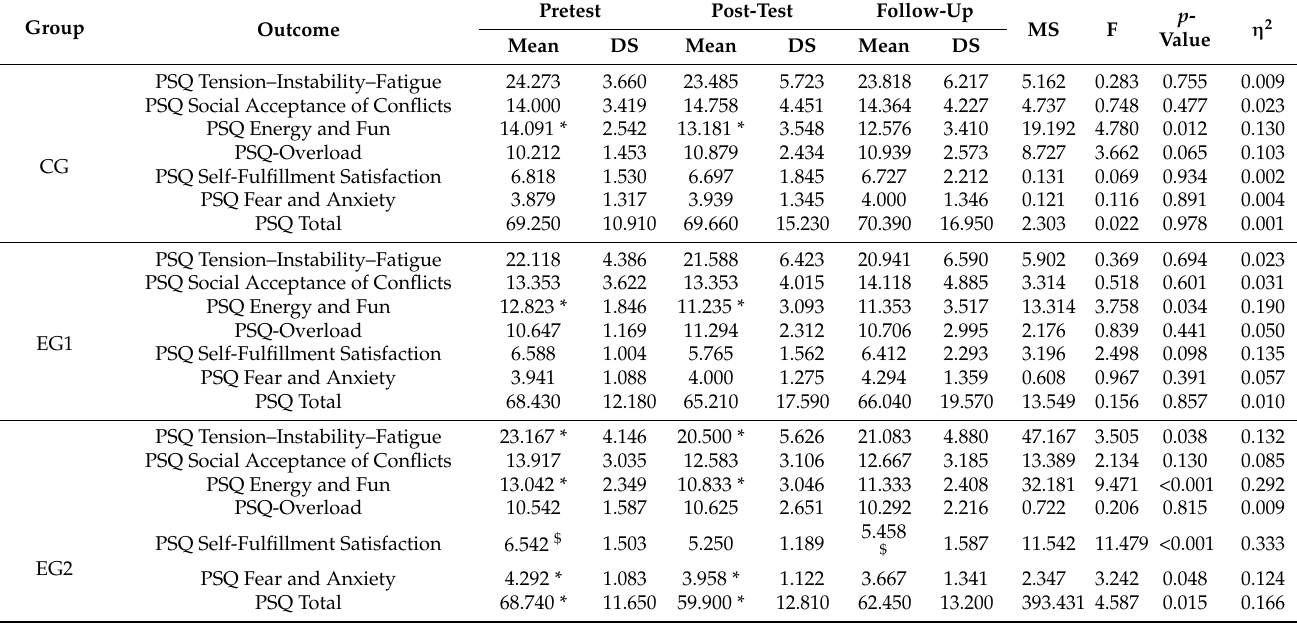
Table 3. Intra-group comparison of PSQ at the same evaluation point, using ANOVA for repeated measures. Pretest Group Outcome